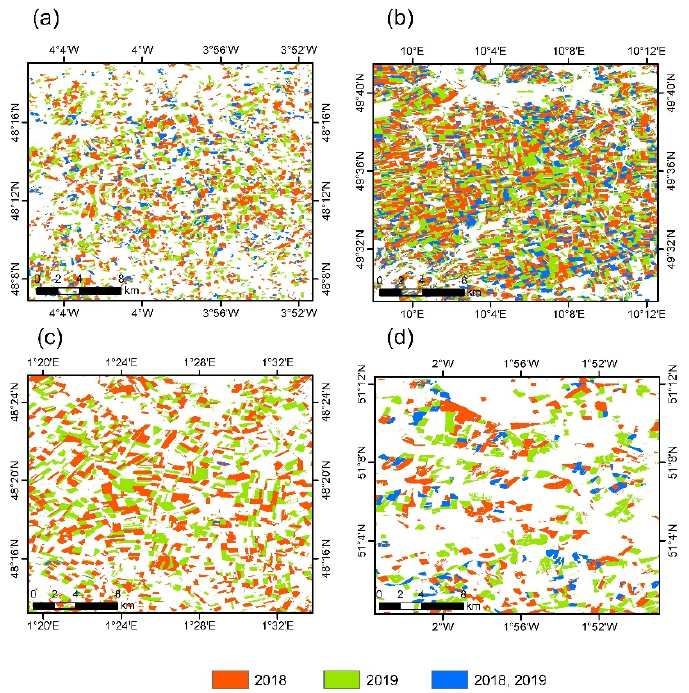
Figure 9. Spatial details of rotation patterns in France ( a , c ), Germany ( b ), and England ( d ) from 2018 to 2019 for maize, winter Triticeae crops, rapeseed, and spring Triticeae crops.